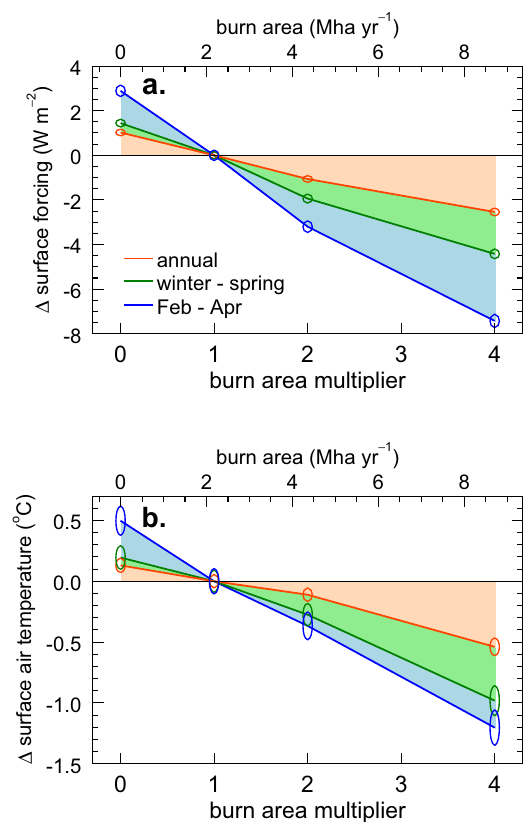
Fig. 8. Surface shortwave forcing (a) and 2-m air temperature (b) changes across the domain as a function of burn area, for three time periods: annual, winter–spring, and February–April. Ellipse heights correspond to standard errors of the means. Net radiation and top of atmosphere energy balance (not shown) displayed similar patterns to (a)